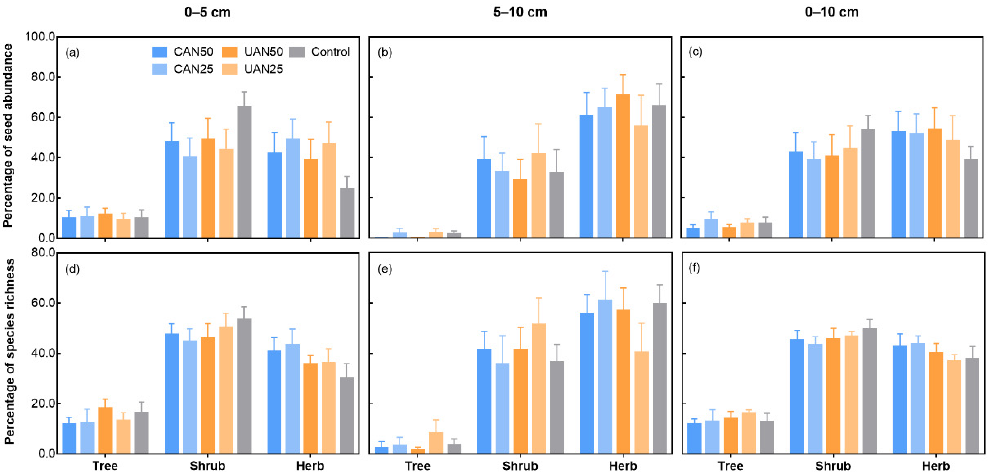
Figure 3. Percentage of seed abundance ( a – c ) and species richness ( d – f ) represented by trees, shrubs, and herbs in the soil seed banks in three soil layers as affected by five N-addition treatments (see Table 1 for details).